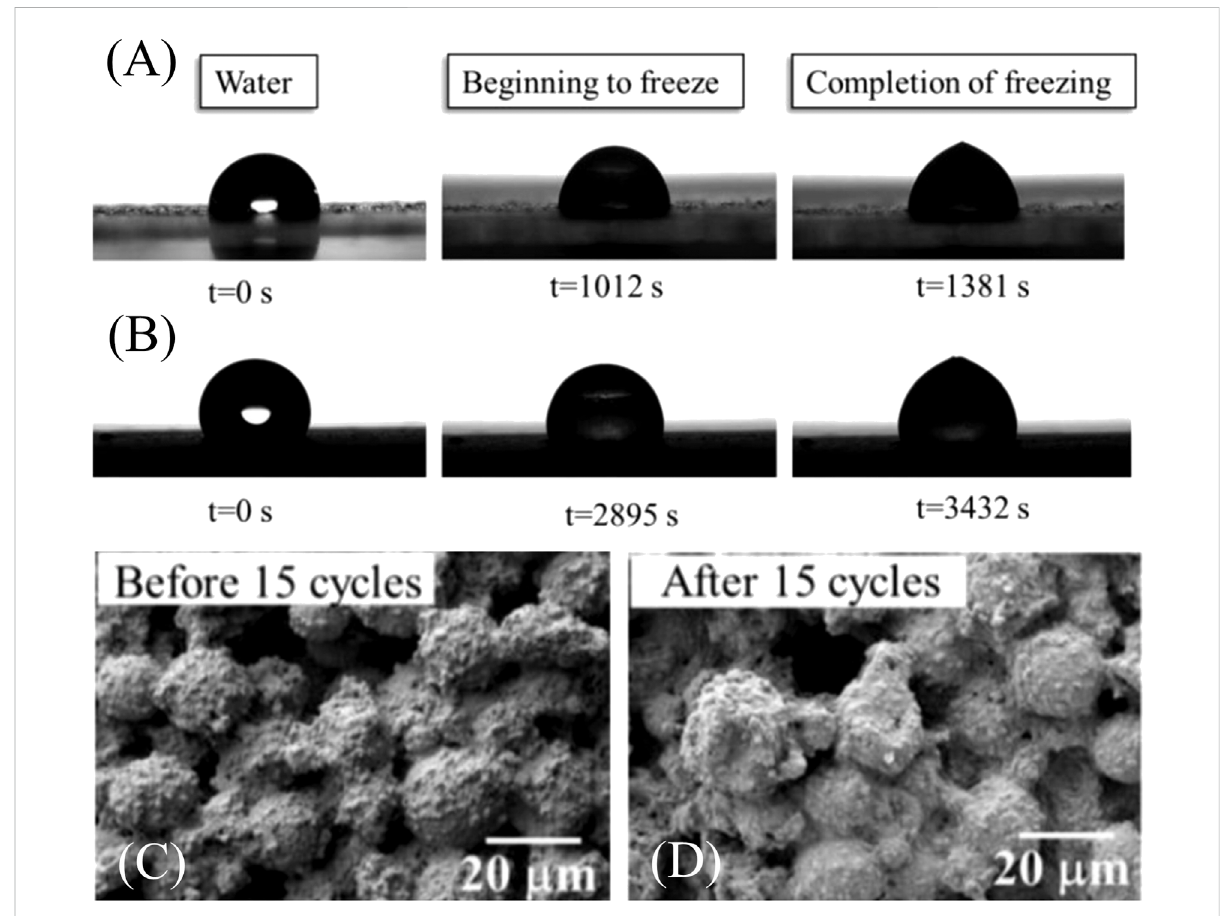
FIGURE 10 Freezingtimeofwaterdropleton (A) PRTVand (B) MPCM/PRTVcoatings(Yuanetal.,2021).TheSEMimagesofMPCM/PRTV coating (C) before 15 icing/melting cycles and (D) after (Yuan et al.,